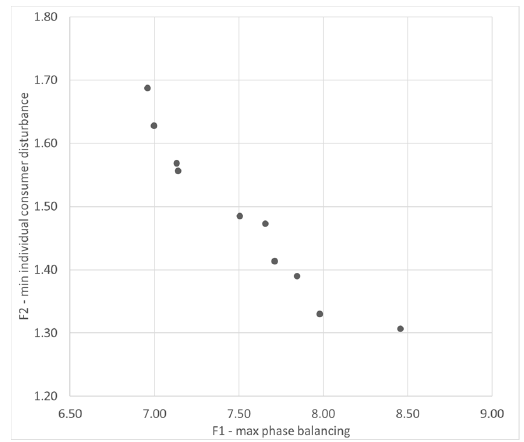
Figure 5. The Pareto frontier for the pair F1–F2. Mathematics 2020 , 8 , x FOR PEER REVIEW